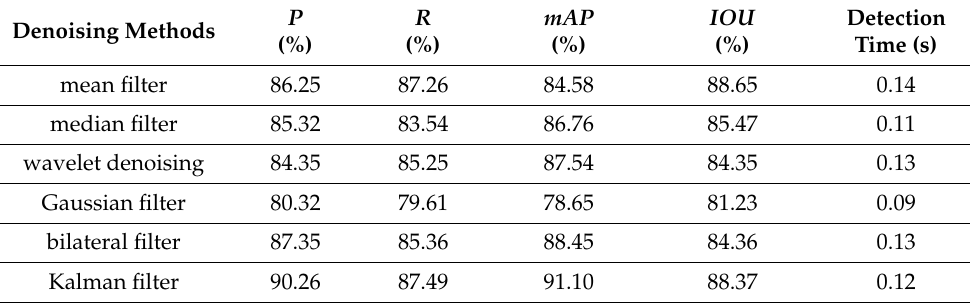
Table 5. Comparison of different denoising